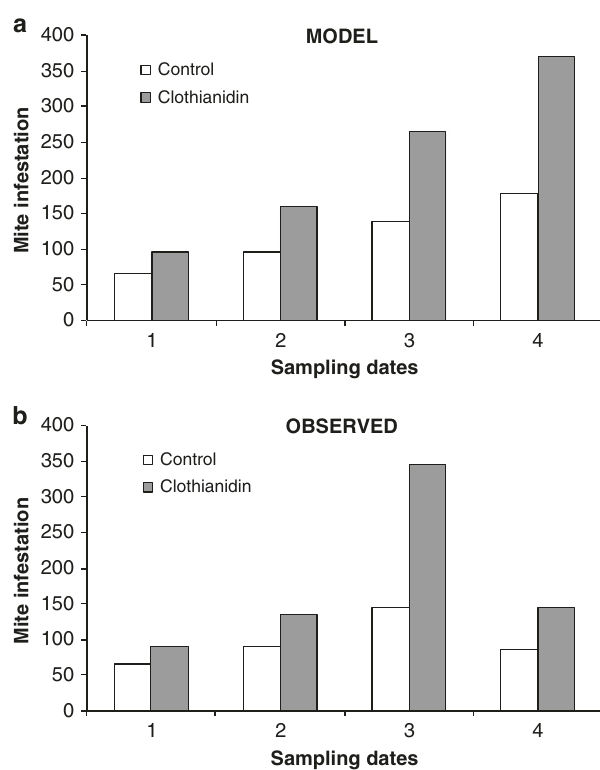
Fig. 4 Comparison between predicted and observed mite infestation of hives at different sampling times during the season. a Mite infestation as predicted using the discrete time model we developed and the reproduction data of Varroa mites as affected by Clothianidin exposure. b Mite infestation observed in hives close to fi elds treated with neonicotinoids 13 .